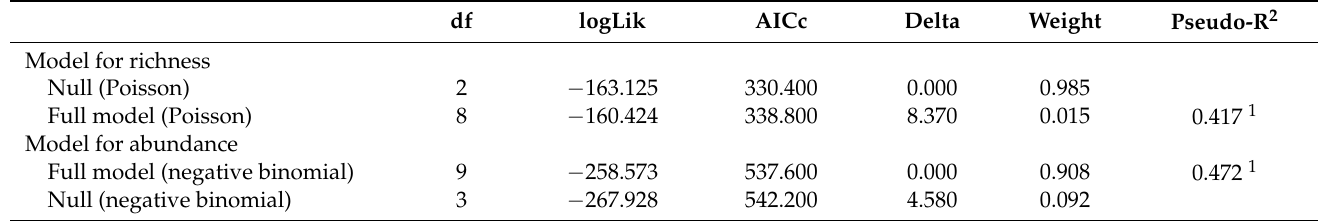
Table 2. Effect of environmental variables in the abundance of fruit-feeding butterfly assemblages of sampled in mixed ombrophilous forest in southern Brazil during November 2016–March 2017 and October 2017–March 2018, according to the model selection. The values of parameters estimated are in the log-link scale. SE—standard error. Bold values indicate the terms that were significant at an alpha threshold of 0.05. Estimate SE z-Value